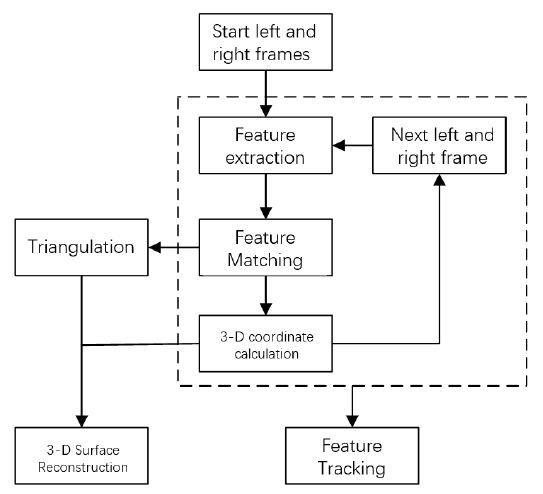
Figure 1. Flow chart of 3D surface reconstruction and feature